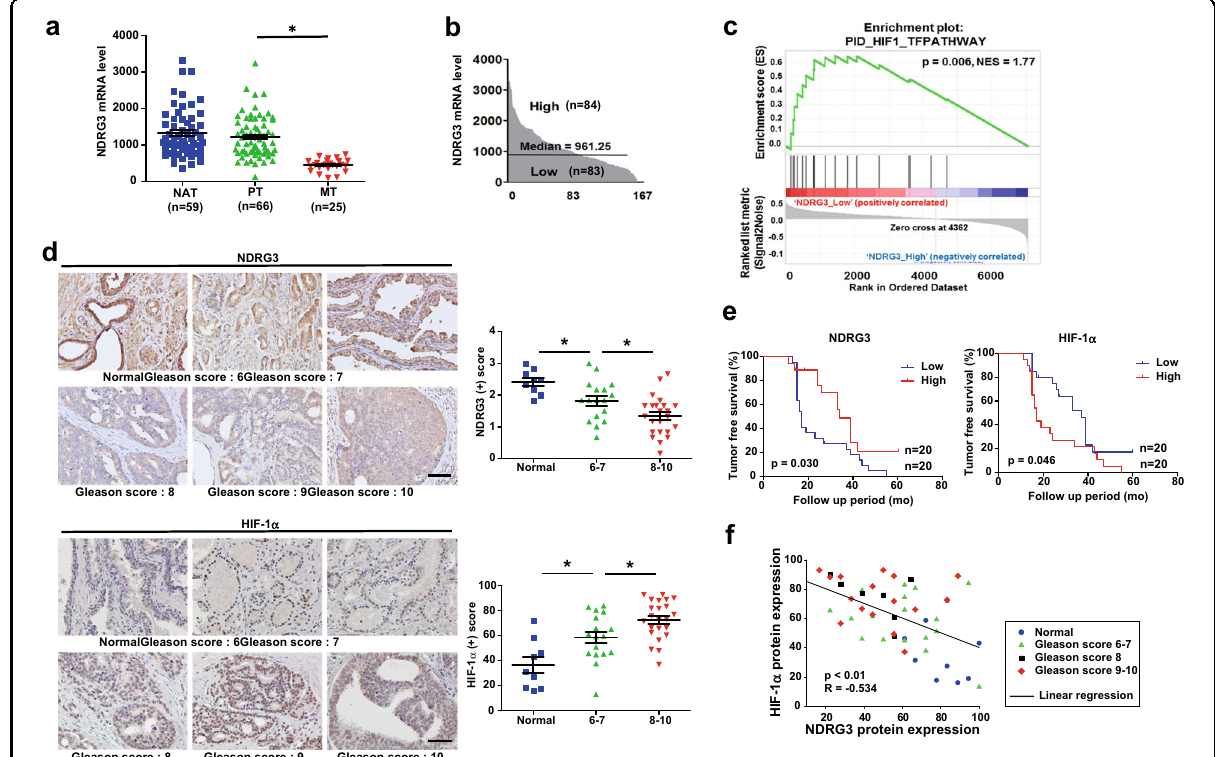
Fig. 7 NDRG3 expression inversely correlates with prostate cancer progression and HIF-1 α expression. a Relative NDRG3 mRNA expression in normal adjacent to tumor tissues (NAT, n = 59), primary tumor tissues (PT, n = 66), and metastatic tumor tissues (MT, n = 25), which were obtained from GEO data set GSE6919. b The GSE6919 data set is divided into NDRG3_Low and NDRG3_High groups according to the median value (961.25) of the NDRG3 mRNA level. c The GSEA enrichment plot for the PID_HIF1_TFPATHWAY gene set in the NDRG3_Low group. d IHC analyses of NDRG3 and HIF-1 α protein expressions in a human prostate adenocarcinoma tissue microarray. Representative images are shown on the left and dot plots of the immunostaining scores are shown on the right. The scale bar represents 50 μ m. e Kaplan – Meier analysis for the association of NDRG3 or HIF-1 α expression and the tumor-free survival rates in the human prostate adenocarcinoma tissue microarray. The Low and High groups were categorized according to the median values of the protein expressions. P -value was calculated by log-rank test. f Pearson correlation analysis shows a negative correlation between NDRG3 and HIF-1 α expression in the tissue microarray. R value indicates the Pearson correlation coef fi cient value. The horizontal lines in all dot plots represent the means ± s.e.m. and * denotes P < 0.05 between the indicated